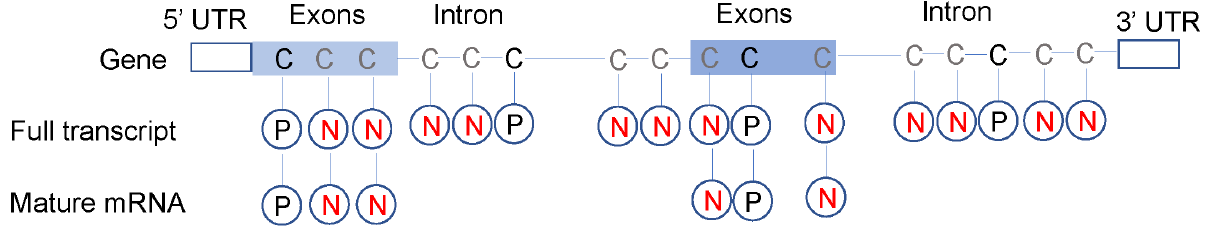
Figure 2. Full transcript model and mature mRNA model. To select negative sites, the unmodified sites and methylated sites un-regulated by NSUN2/YBX1/ALYREF from the intron and exons were both considered in the full transcript model; whereas the mature mRNA model only considered sites from exons. As most captured sequences during library preparation are exons (mature mRNA) due to polyA selection, the performance of full transcript model will be overestimated.